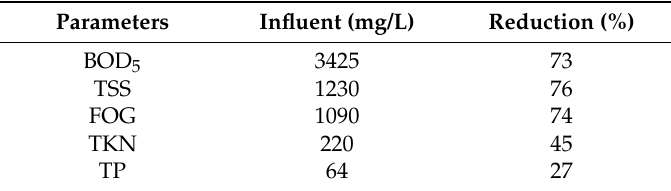
Table 16. Field trial results for tannin-based coagulant tested on beef wastewater